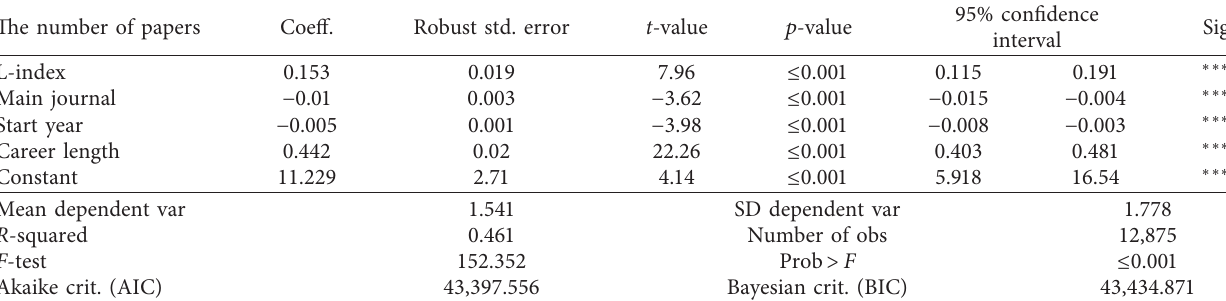
Table 5: Unary linear regression results of the number of papers and L-index.